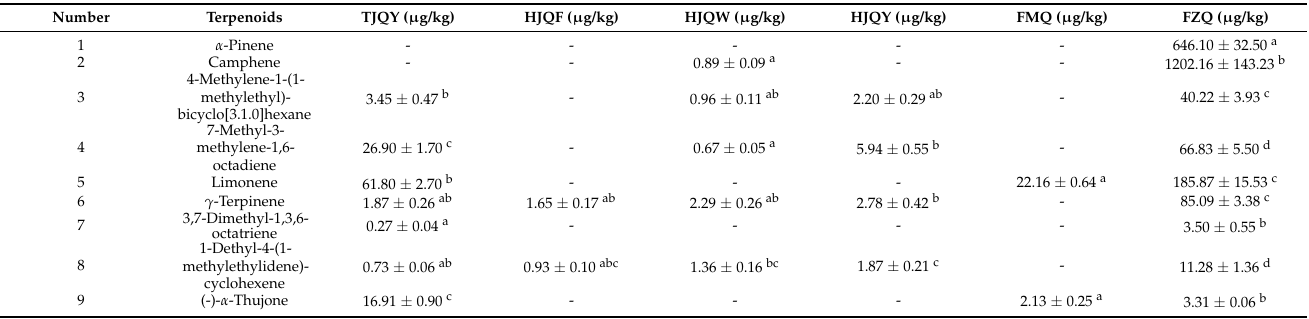
Table 1. Contents of terpene compounds in six